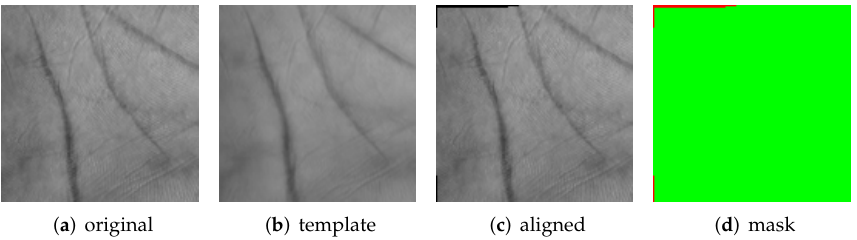
Figure 6. Example of data alignment. The template is the output of PT-net trained with original PolyU dataset. ( a ) original; ( b ) template; ( c ) aligned; ( d ) mask. In ( d ), areas of ones are filled with green pixels, while a red pixel represents a zero. When the two images are severely misaligned, our method can effectively align the